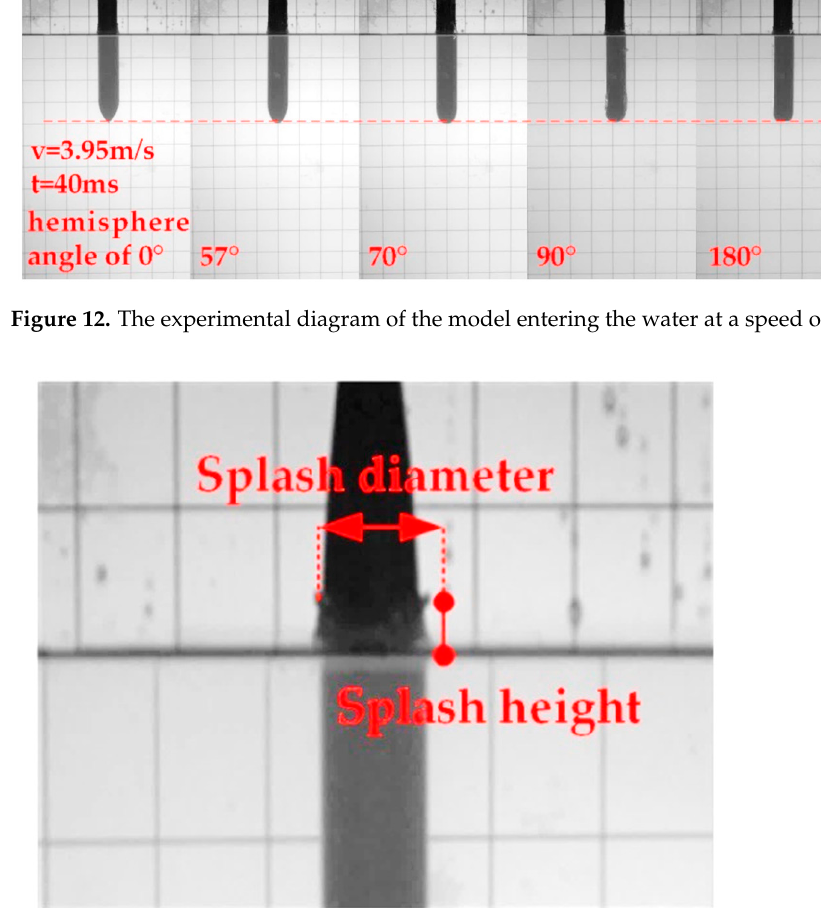
Figure 13. The splash diagram of the hydrophilic model with the initial velocity of water entry v = 3.95 m/s and the head shape hemispherical angle of 0°.